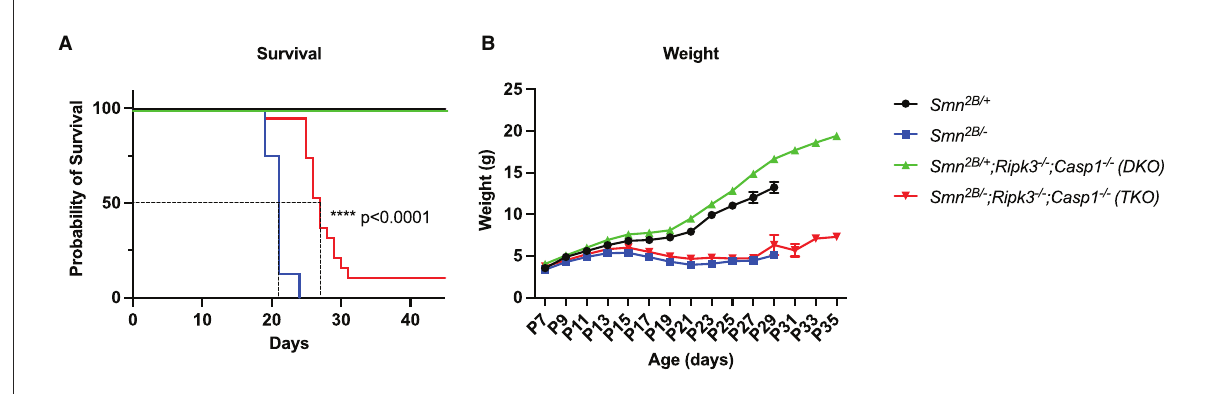
FIGURE2 Impact of necroptotic pathway ablation on survival and weight gain in Smn 2 B / − mice. (A) Kaplan–Meier curve comparing survival across genotypes up to 50 days displays increased survival in TKO mice compared to Smn 2 B / − ( p < 0.001). (B) Analysis of weight beginning at P7 to P35,